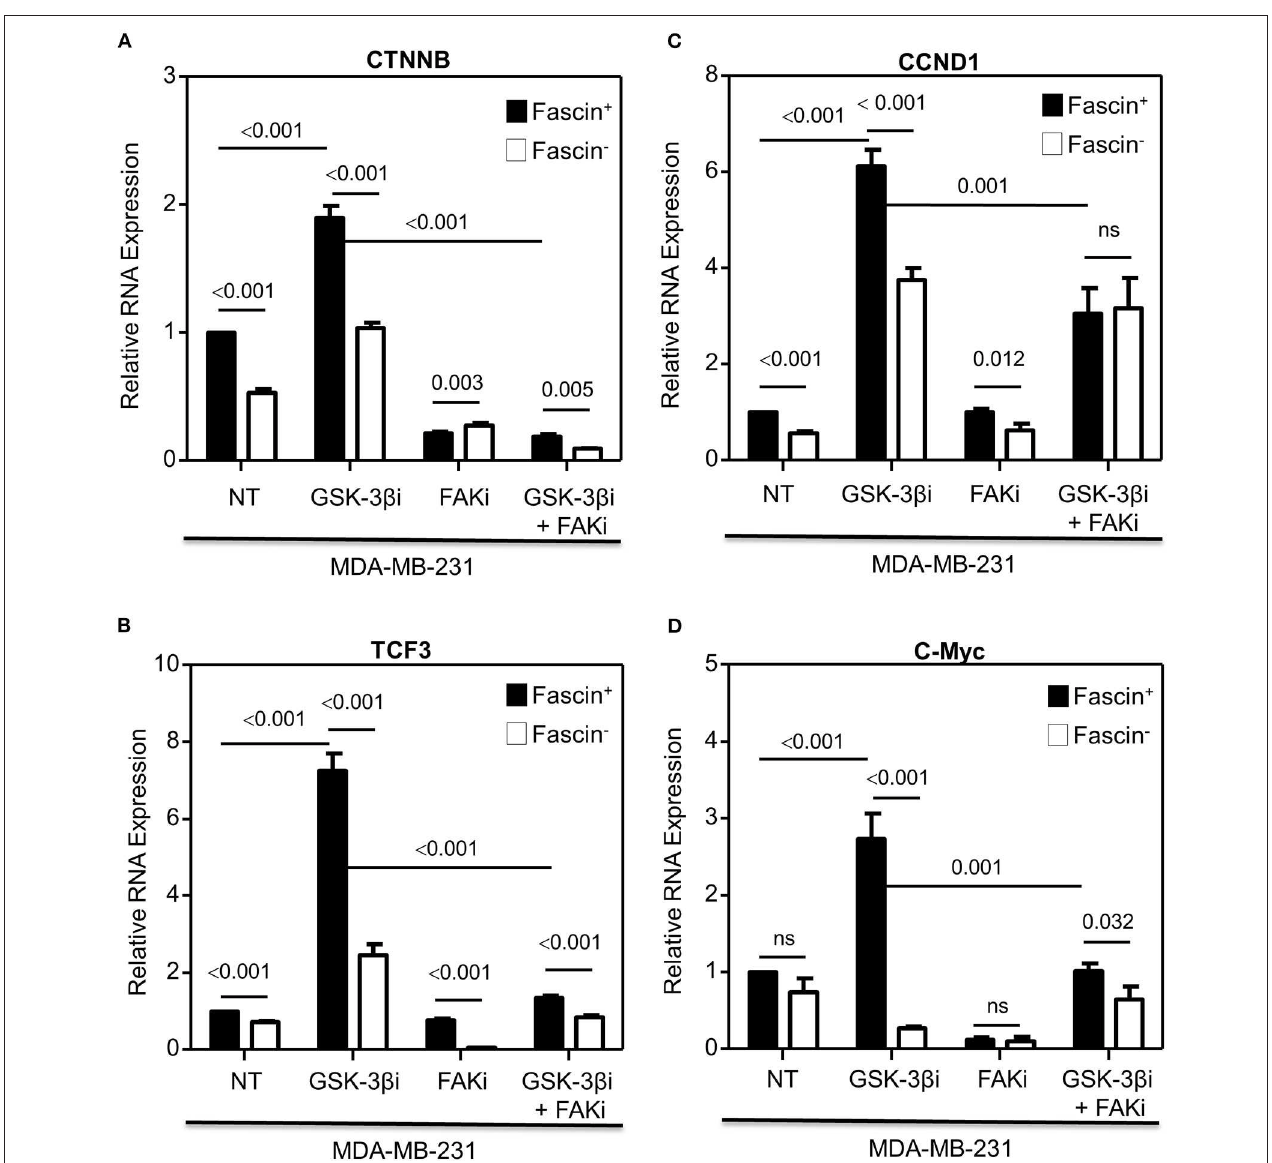
FIGURE 2 | (A–D) Fascin activation of β -catenin downstream target genes is FAK-dependent. Bar graph showing relative RNA expression of CTNNB (A) , TCF3 (B) , CCND1 (C) , and c-Myc (D) following fascin knockdown in MDA-MB-231 cells before and after treatment with GSK-3 β i ± FAKi. Results showing the mean of triplicates ± SD of three independent experiments, and each gene is normalized to the expression levels of untreated fascin +